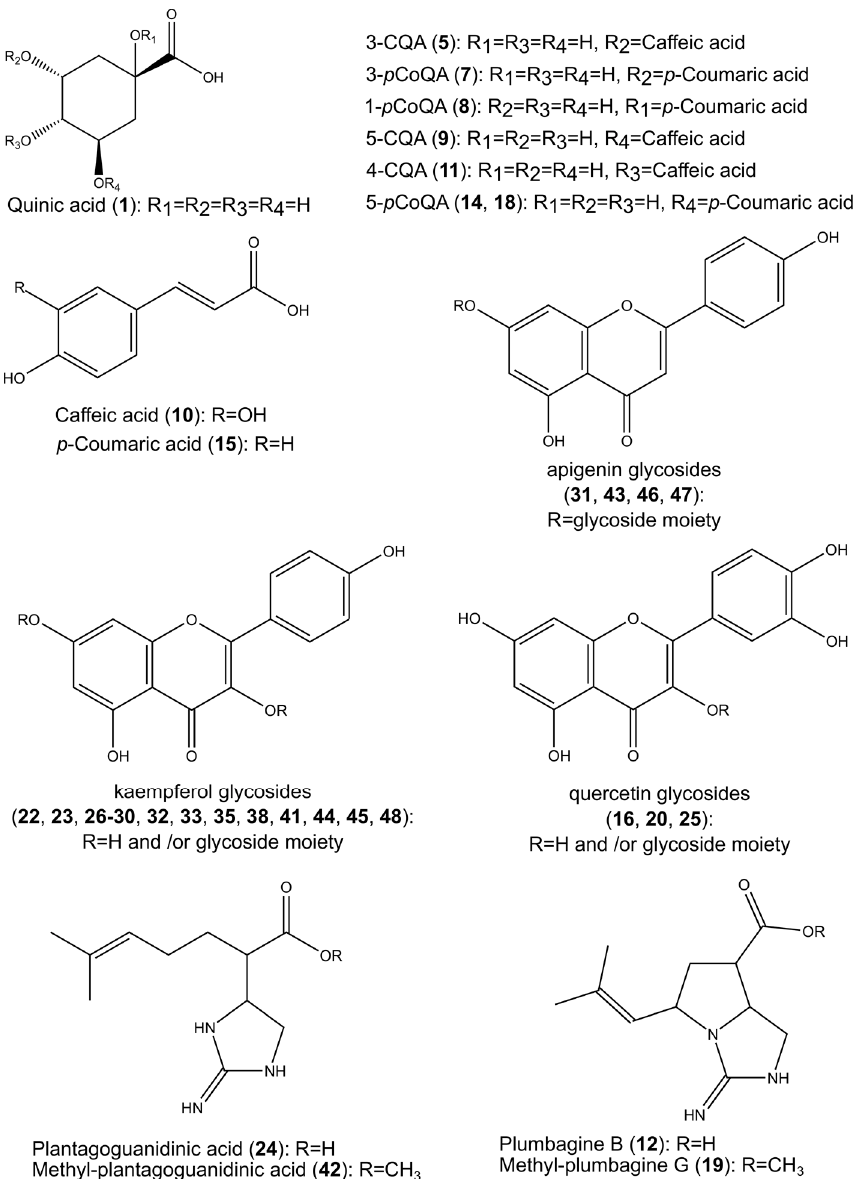
Figure 2 . General structures and substitution patterns of phenolic acids, flavonoids, and alkaloids found in Z . elegans inflorescences.